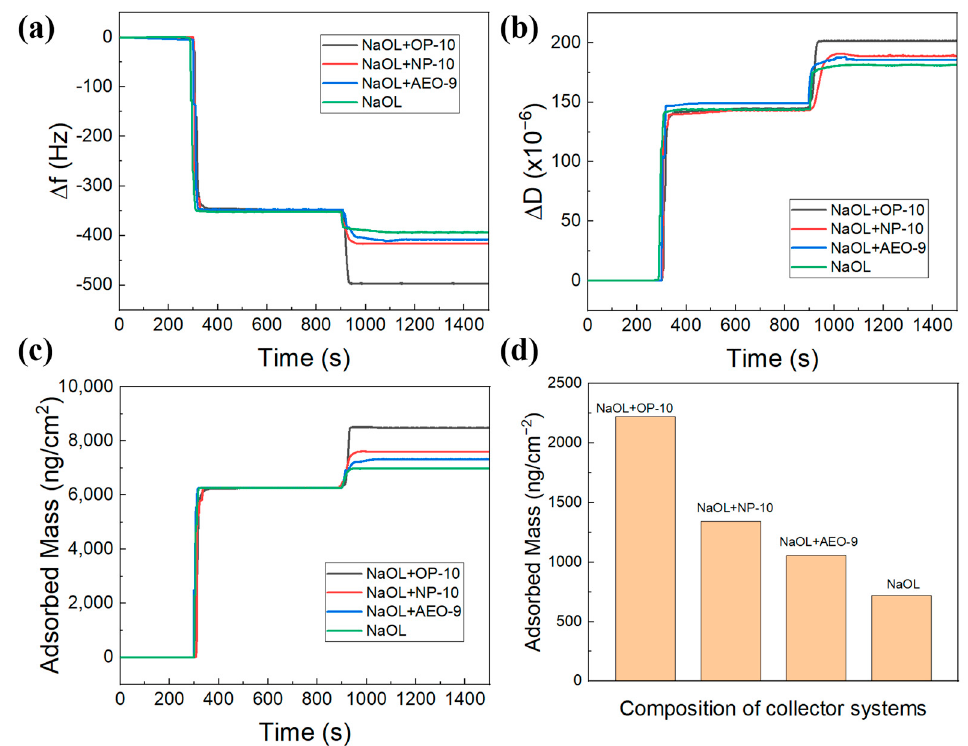
Figure 4. Real ‐ time change in Δ f ( a ), Δ D ( b ) and adsorbed mass ( c ) of the Ca 2+ ‐ activated silicon dioxide sensor associated with different collector systems (NaOL, NaOL + OP ‐ 10, NaOL + NP ‐ 10 and NaOL + AEO ‐ 9); ( d ) The adsorbed mass of oleate on the sensor without and with the synergy of OP ‐ 10, NP ‐ 10 and AEO ‐ 9.